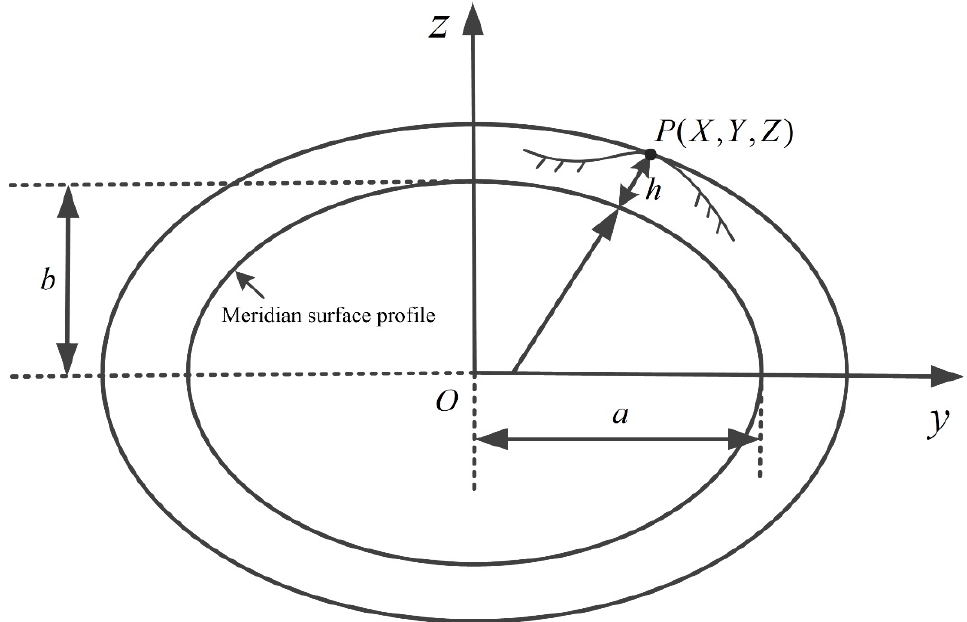
Figure 1. Approximate reference ellipsoidal meridian profile where the ground user’s geodetic height is located.